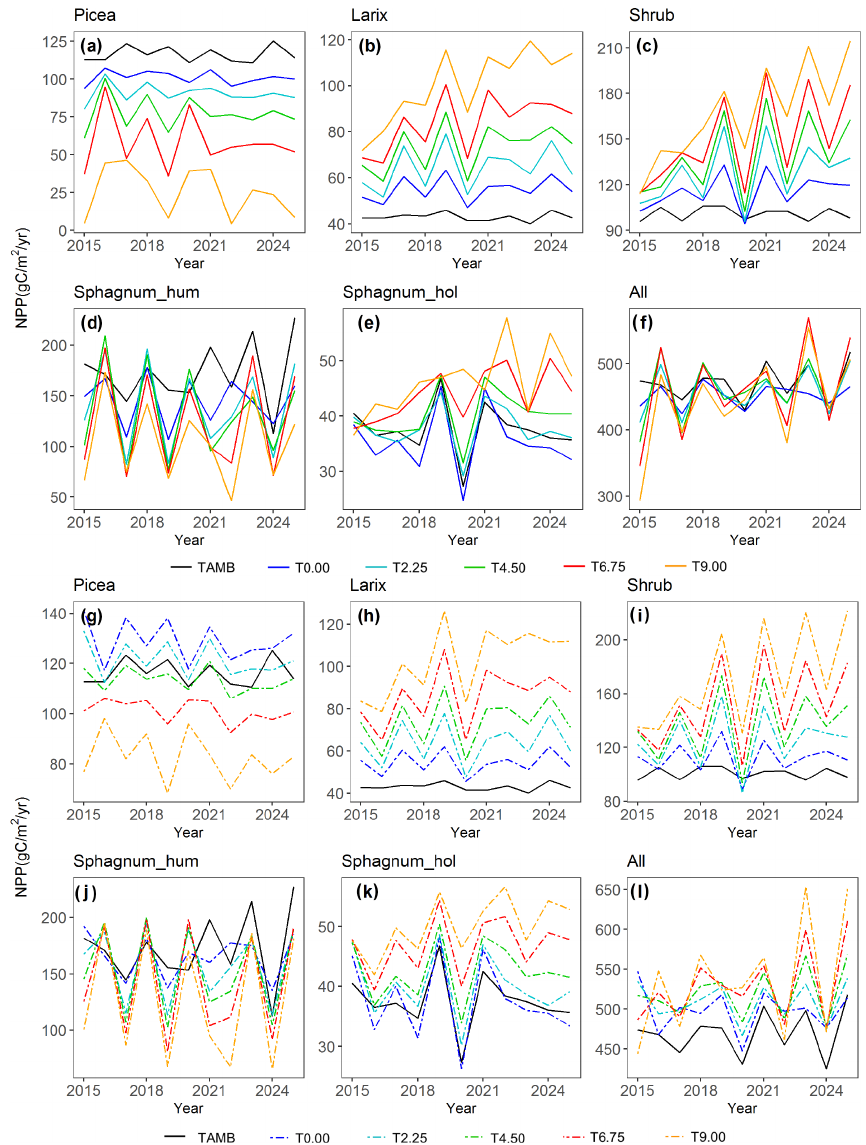
Figure 5. Predicted NPP response to warming with ambient atmospheric CO 2 ( a–f , solid lines) and warming with elevated atmospheric CO 2 concentration ( g–l , dashed lines). The solid black line TAMB is the ambient temperature and CO 2 case, and T0.00 to T9.00 means increasing temperature from 0 to 9 ◦